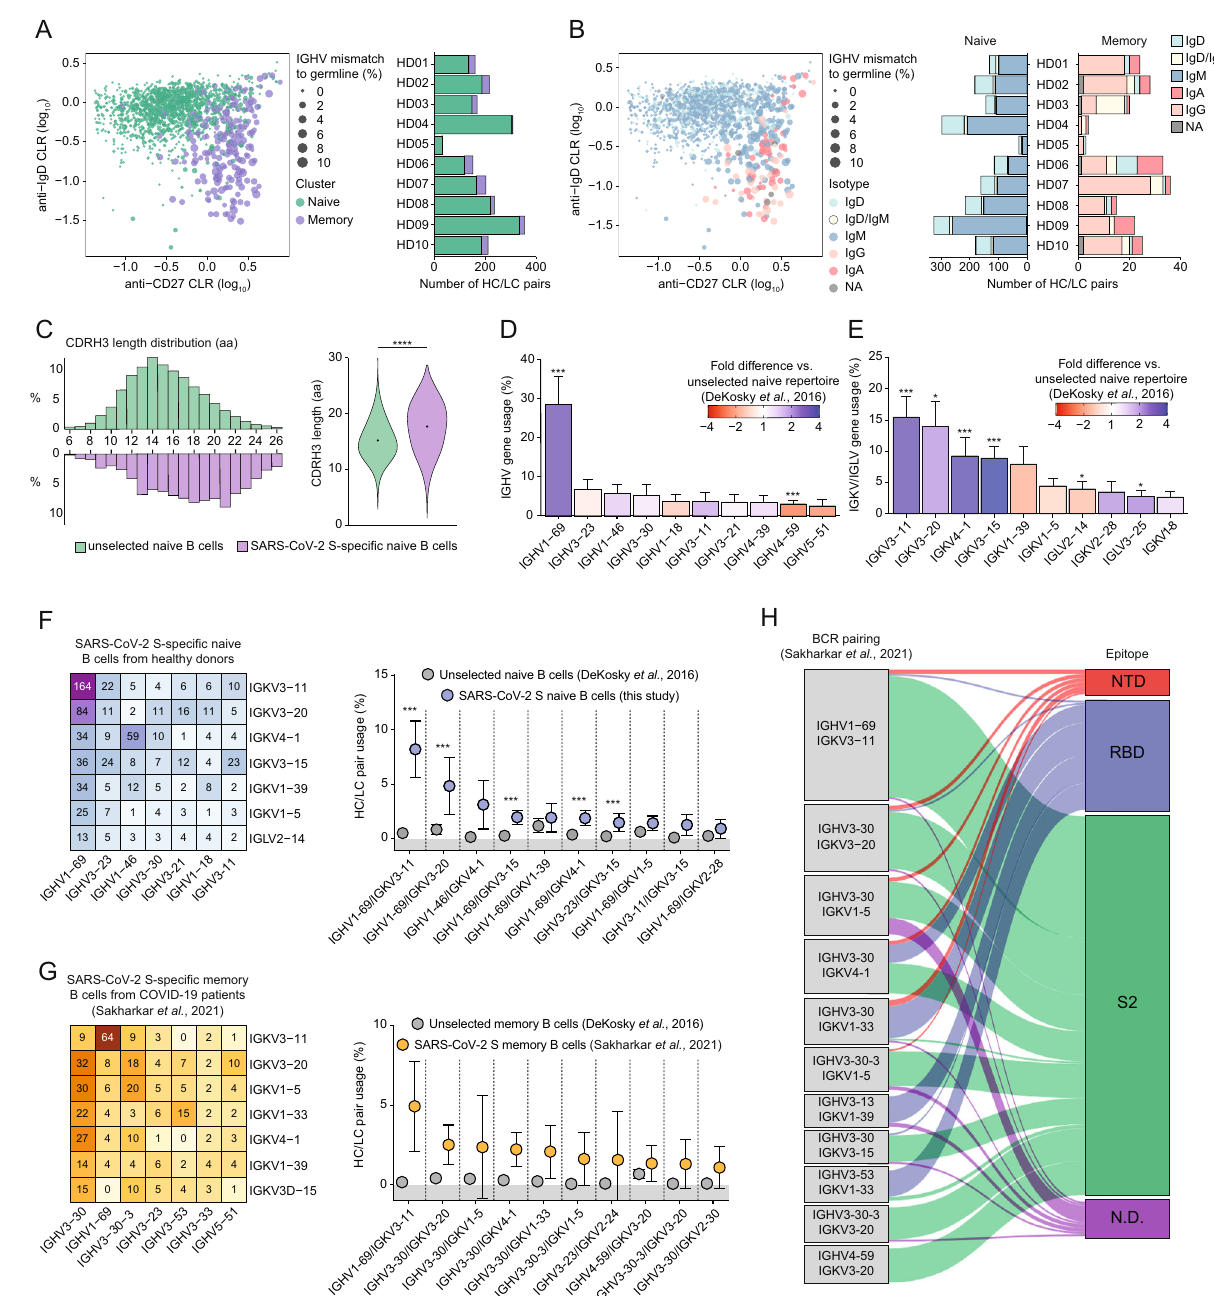
Fig. 3 | A public antibody class dominates the SARS-CoV-2 S-reactive B cell repertoire. A Jittered dot plot showing the phenotype of individualB cells and bar plot showing the number of recovered sequences per HDper cluster,from 10HDs. Each dot represents an individual B cell, with the size of the dot corresponding to the percentage of mismatches to the IMGT-assigned germline sequence for IGHV genes. B DotplotshowingtheisotypeofindividualBcellsandbarplotshowingthe number of recovered sequences per HD per isotype, separated per cluster as determinedin( A ).NAnotapplicable;ifnoisotypecouldberetrieved. C Heavychain complementarity-determining region 3 (CDRH3) lengths in amino acids (aa) for naive SARS-CoV-2 S-reactive B cells (purple) and an unselected naive B cell repertoire 35 (green). Signi fi cance was calculated with a Mann – Whitney U test. D , E Barplotsdepictingthemean±SEMIGHV( D )andIGKV/IGLV( E )geneusage(%) in naive SARS-CoV-2 S-reactive B cells from nine HDs. The colorsrepresent the fold